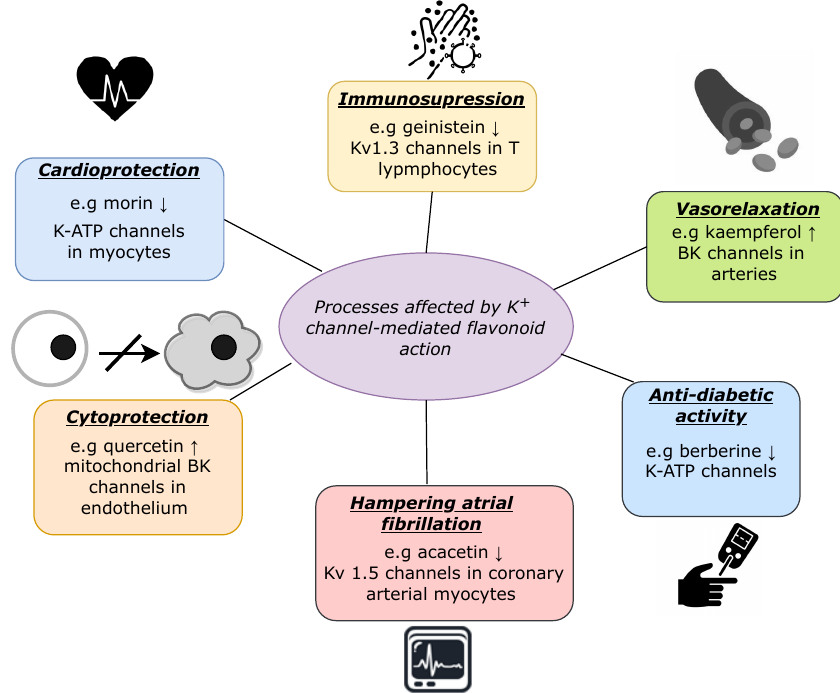
Figure 2. A graphical representation of the selected important biological processes that can be affected by flavonoid administration, for which the molecular control mechanism can be, at least, partially explained by the K + channel modulation (with appropriate examples). The ↑ represents channels’ activation and ↓ denotes channels’